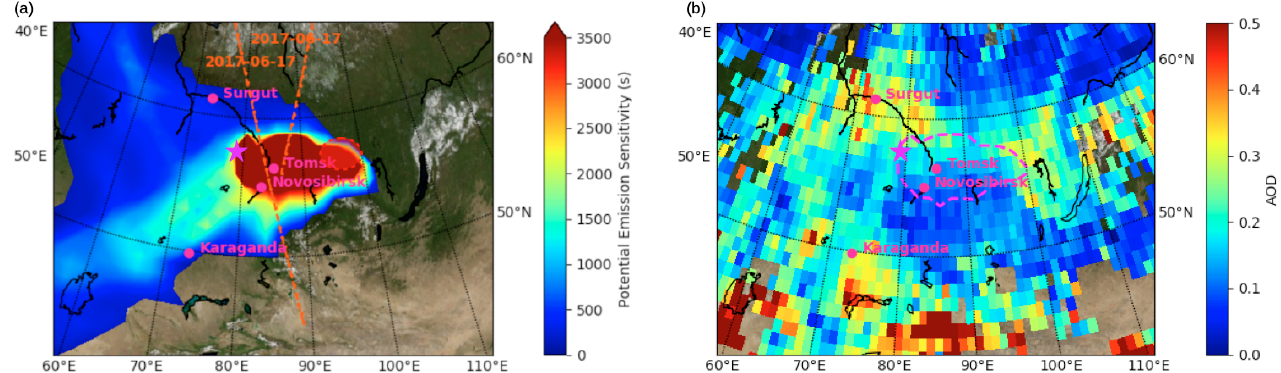
Figure 15. ( a ) as Figure 4a for the aerosol layer of Figure 14. Orange dotted lines are the two CALIOP overpasses on 17 June 2017 at 6 UT and 19 UT. ( b ) as Figure 4b with averaging of MODIS AOD 550 from 15 to 18 June 2017.